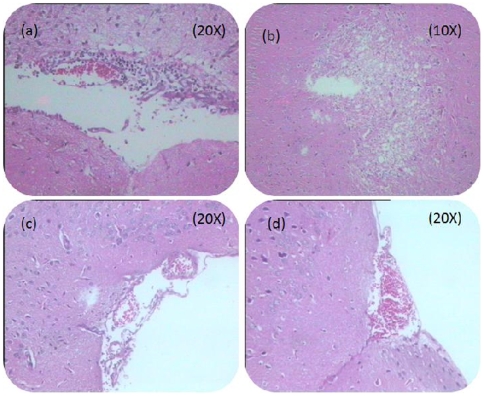
Histopathology of mice brain treated with P-2 siRNA.Hematoxylin and eosin-stained vertical brain sections from control mice treated with ncsiRNA and infected with CHPV (a, b) and P-2 siRNA treated mice on 5th day PI (c, d) at indicated magnifications.